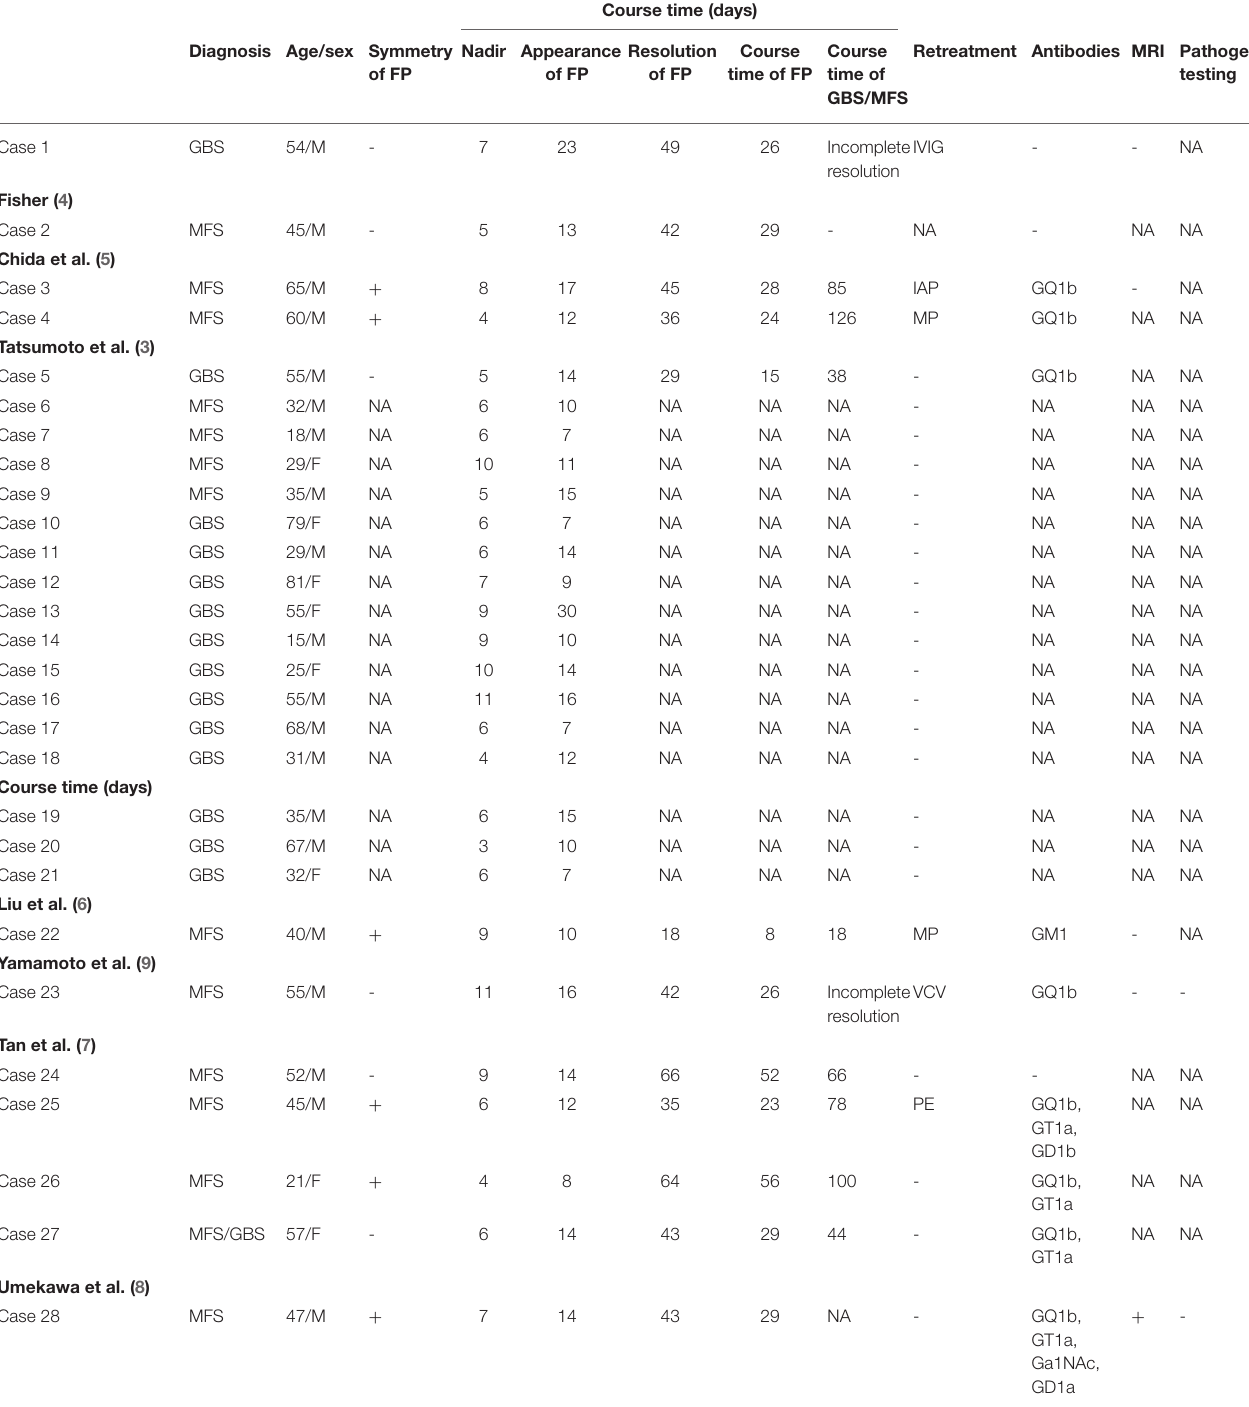
TABLE 1 | Review all reported GBS/MFS with DFP cases.